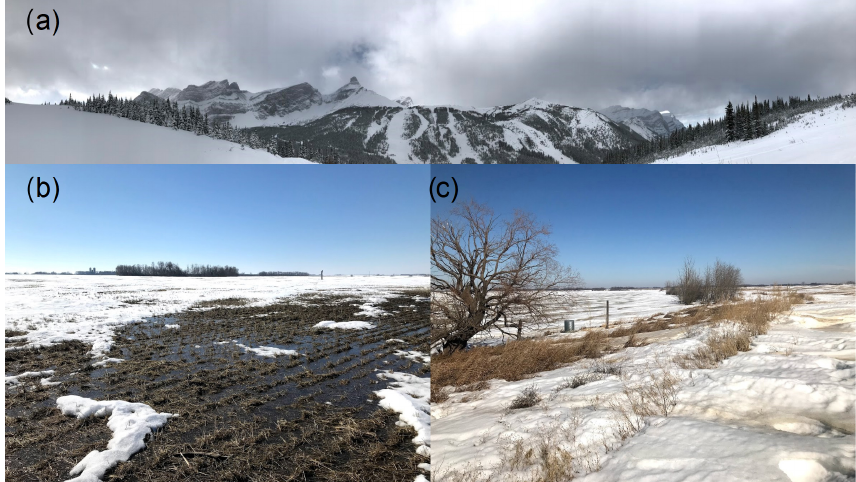
Figure 1. (a) Fortress Mountain Snow Observatory in Kananaskis, Alberta, Canada, and (b) Rosthern and (c) Clavet prairie study locations in Saskatchewan, Canada. Data collection was centred on Fortress Ridge (ridgeline in background centre), an area of high topographic variability and a mix of dense forests and clearings. The Rosthern photo highlights the low vertical relief of upland areas and isolated woodlands amongst cultivated fields. The Clavet photo highlights the transition zone between the open upland agricultural terrain and the lower-elevation vegetated wetland.